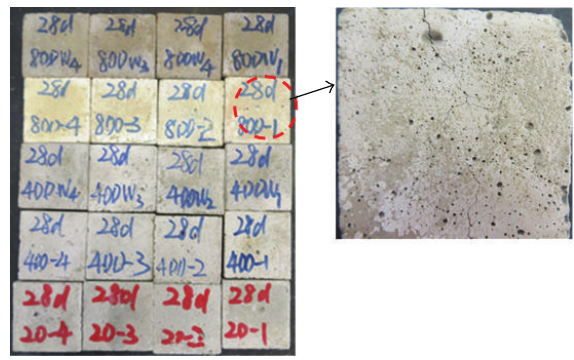
Figure 3: Color changes and surface cracks of postfire specimens.